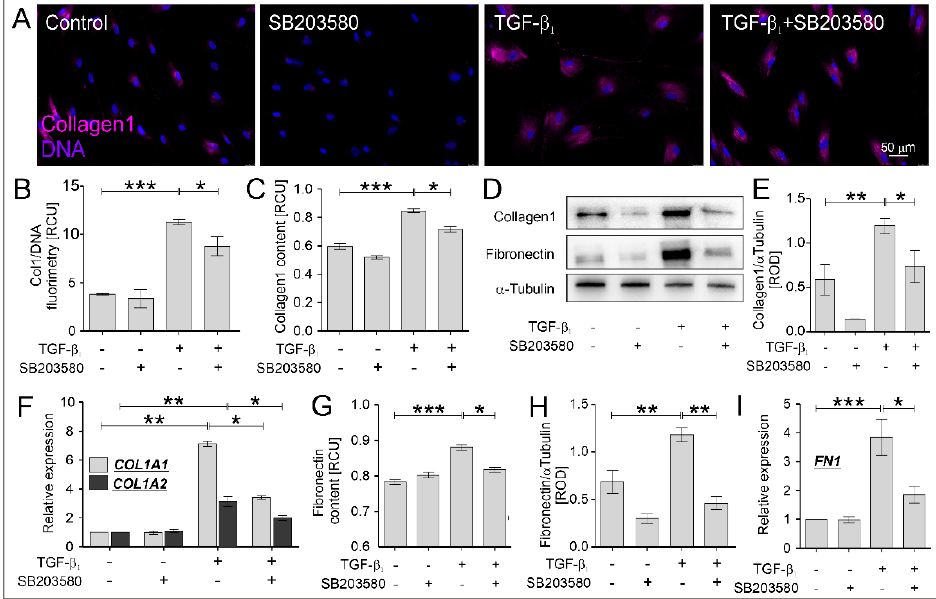
Figure 3. ECM-related myofibroblast markers were significantly reduced by SB203580 in TGF- β 1 - treated HBF AS cultures. HBF AS populations were cultured without or with SB203580 (10 µ M) in the absence or presence of TGF- β 1 (5 ng/mL) for five days. ( A ) Representative images of HBFs AS, immunostained for collagen1 (magenta) and counterstained for DNA (blue), were obtained. Scale bar = 50 µ m. The levels of collagen1 in HBFs AS cultures ( n = 3) were determined ( B ) fluoro- metrically, ( C ) using in-cell ELISA and ( D , E ) Western blot. The levels of fibronectin in the HBF AS cultures ( n = 3) were determined ( G ) using in-cell ELISA and ( D , H ) Western blot (representative membranes are shown). Relative expression levels of ( F ) COL1A1 (encoding collagen 1A1), COL1A2 (encoding collagen 1A2) and ( I ) FN1 (encoding fibronectin) in the HBFs AS ( n = 4) cultured for one day in conditions described above were presented as a 2 − ∆∆ Ct mean value in relation to control genes ( 18S , B2M and GAPDH ) and control conditions. RCU—relative colorimetric units. Statis- tical significance was tested using the non-parametric Kruskal–Wallis test with Dunn’s Multiple Comparison post hoc test; * p < 0.05; ** p < 0.01; *** p <